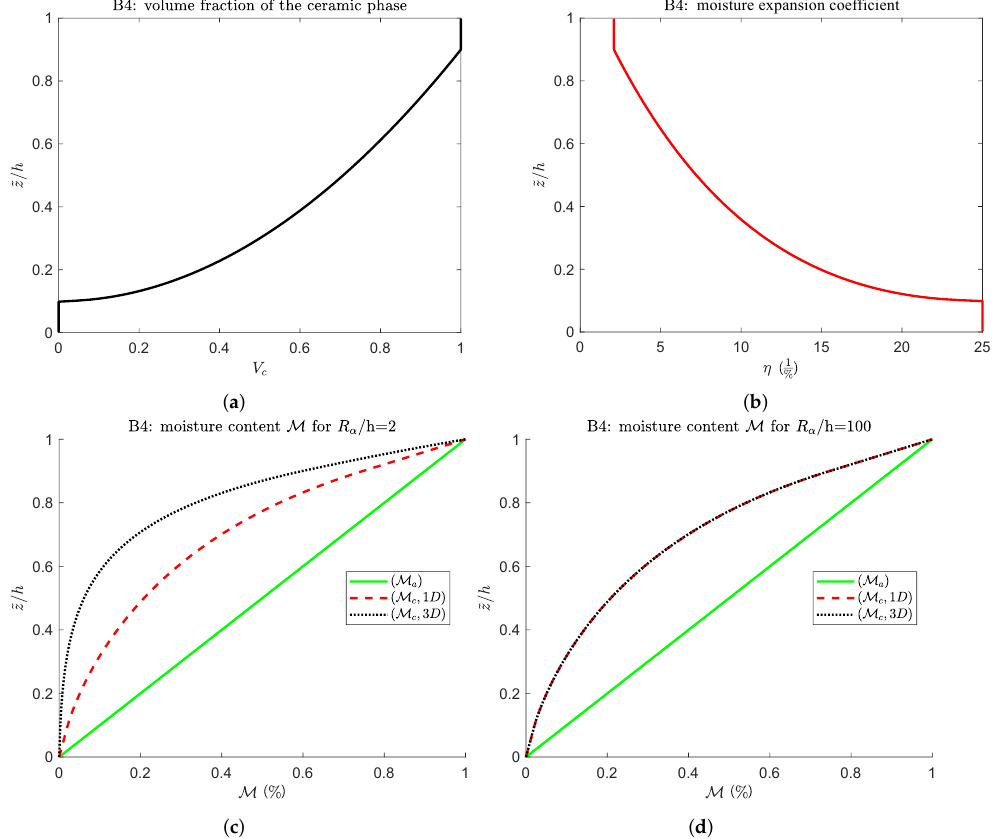
Figure 9. Fourth benchmark: spherical sandwich shell panel featuring a FGM ( p = 0.5) core with an imposed moisture content on the top and bottom surfaces. The figures show the volume fraction of the ceramic phase, the moisture expansion coefficient, and the moisture content profiles for a thick and a thin structure through their thickness. ( a ) Volume fraction of the ceramic phase V c . ( b ) Moisture expansion coefficient η . ( c ) Moisture content profile of the R α / h = 2 shell. ( d ) Moisture content profile of the R α / h = 100